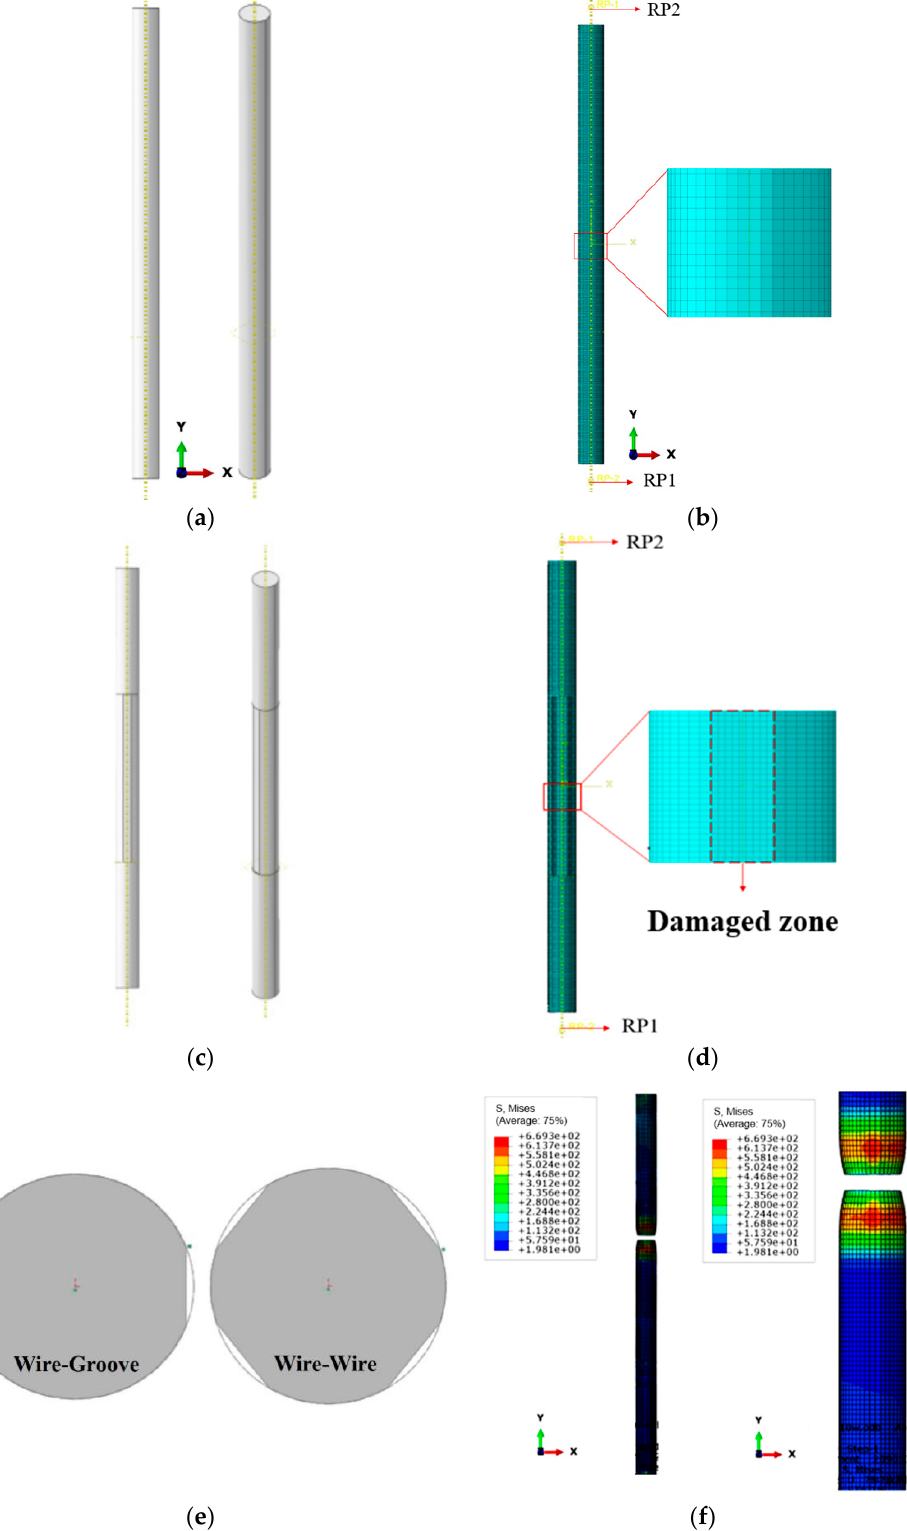
Figure 6. Finite element model of the fatigue wire. ( a ) Three-dimensional model of the unworn wire; ( b ) finite element model of the unworn wire; ( c ) three-dimensional model of the worn wire; ( d ) finite element model of the worn wire; ( e ) cross-section of the worn wire; ( f ) tensile fracture diagram of the worn wire.